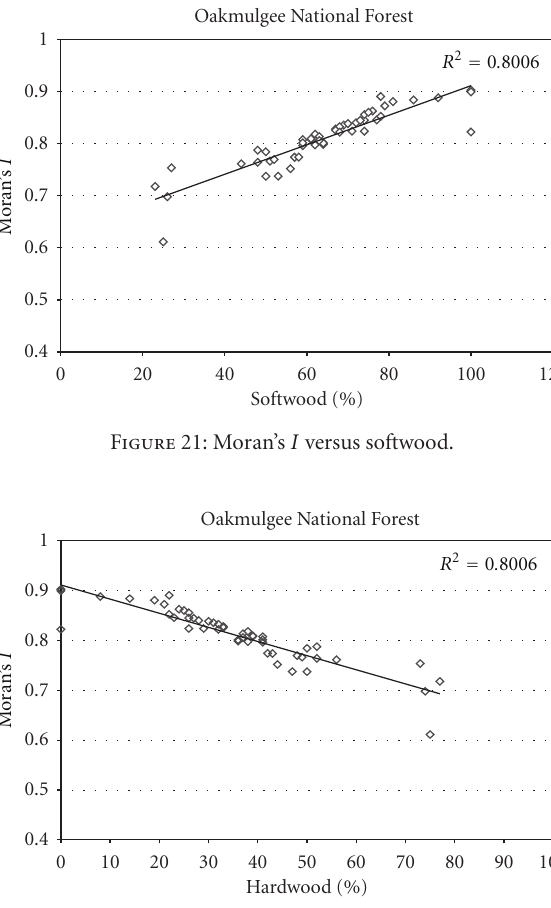
Figure 22: Moran’s I versus